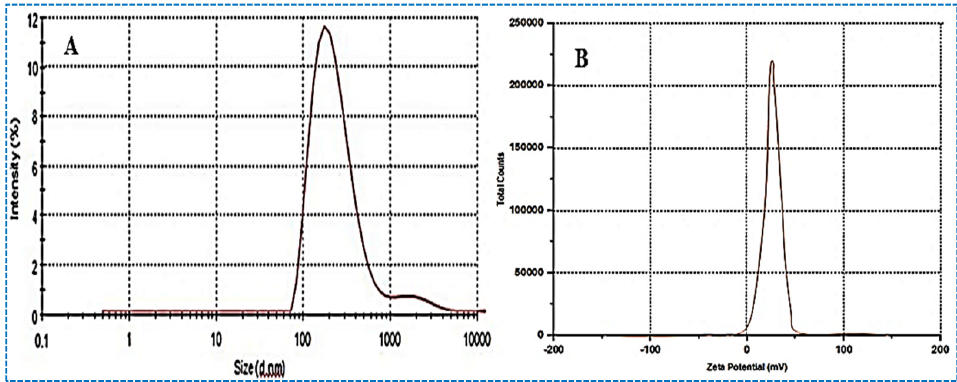
Figure 4. Hydrodynamic diameter ( A ), and zeta potential ( B ) image of optimized